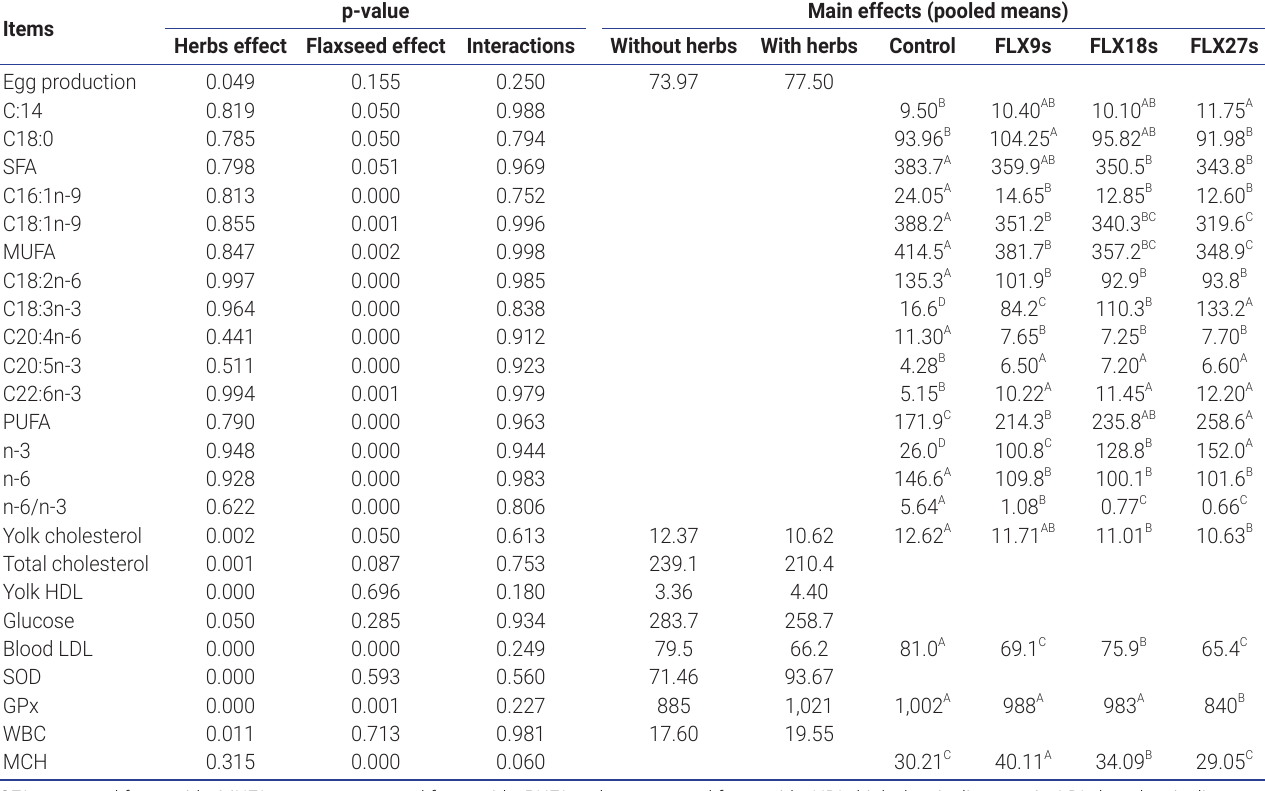
Table 3. The results of two-way analysis of variance analysis for measured flaxseed-herbs effect